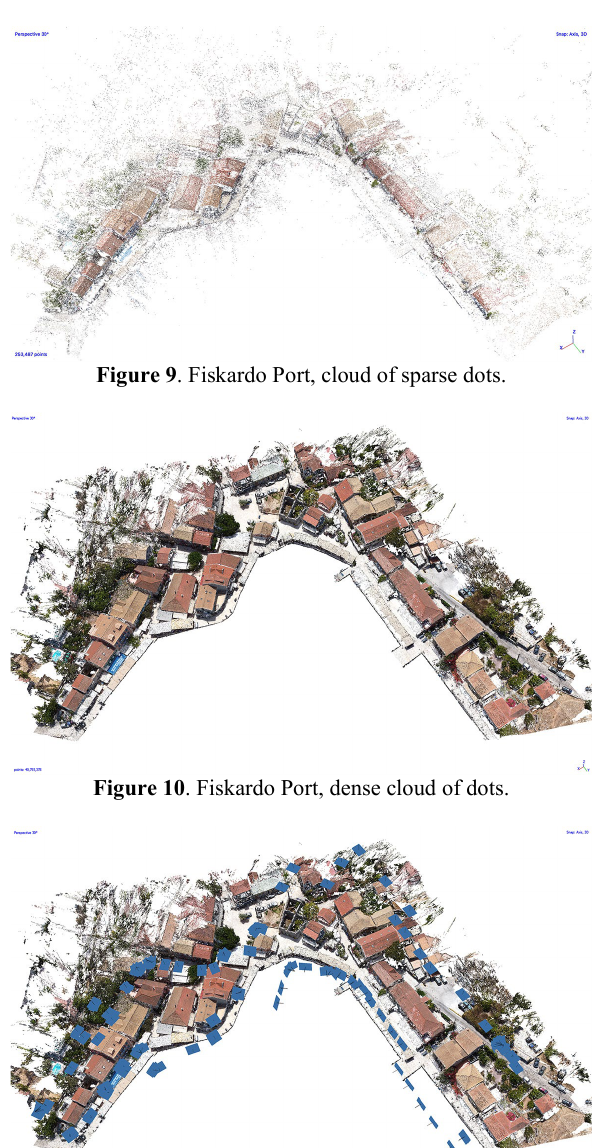
Figure 11 . Fiskardo Port, dense point cloud with identification of the